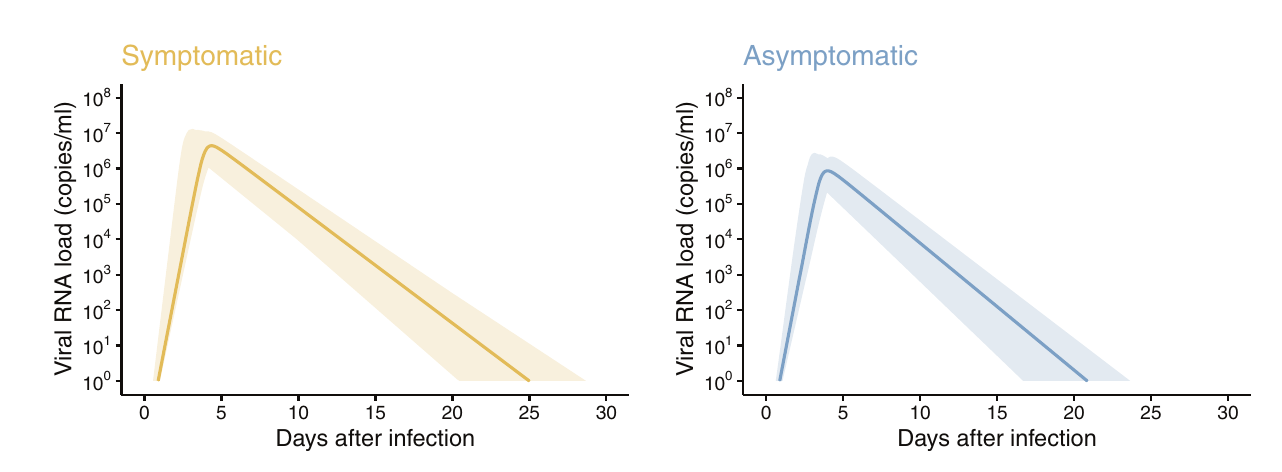
fi t parameters of fi xed effect. The shaded regions correspond to 95% prediction intervals. The 95% prediction intervals were created using bootstrap